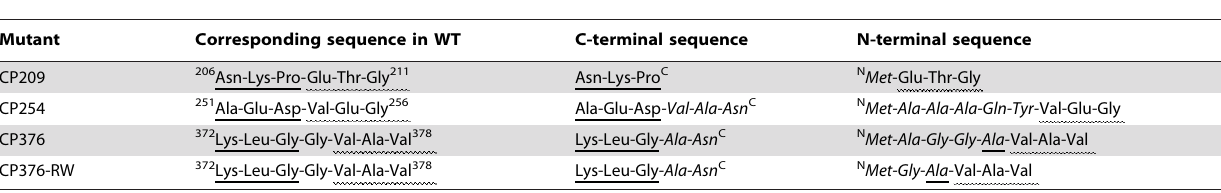
Table 1. N- and C- terminal sequences of the circularly permuted GroEL subunits constructed in this study.